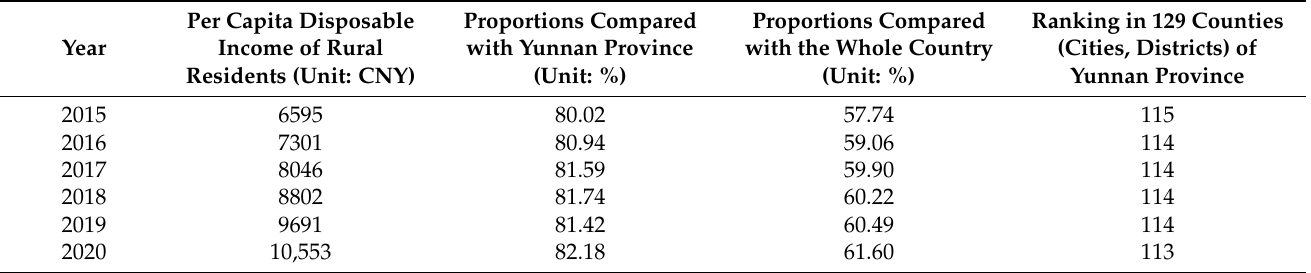
Table 1. Rural Per Capita Disposable Income and Its Ranking in Luquan County from 2015 to 2020.